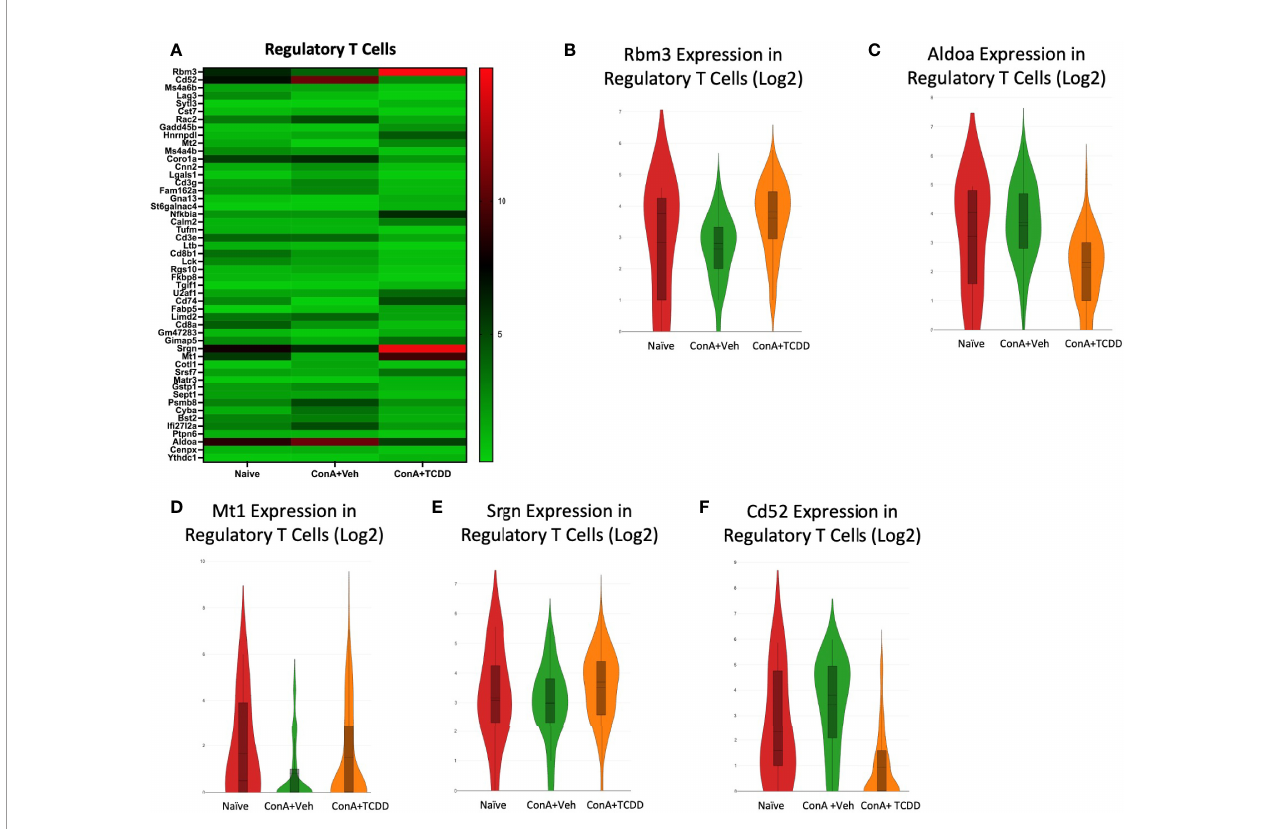
FIGURE 8 | Elucidation of Regulatory T cell transcription pro fi les. C57/BL6 mice were injected with ConA followed by vehicle or TCDD 1 hour later as described in Figure 1 legend. Liver in fi ltrating cells were isolated and scRNA-seq was performed as described in Methods. Heatmaps consisting of the top 50 differential genes per treatment were generated using Loupe Browser. Heatmaps of differentially expressed genes from (A) Regulatory T cells. (B – F) Violin plot of Log2 expression of target